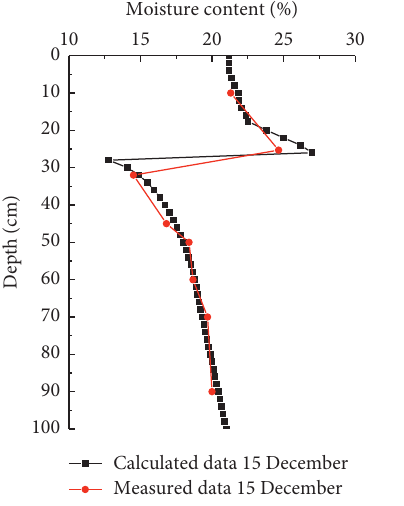
Figure 7: Numerical calculation results of moisture field.